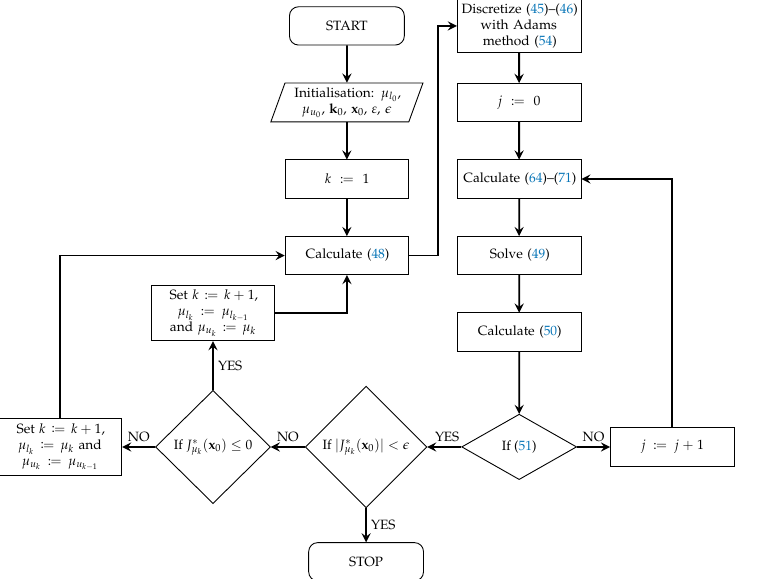
Figure 2. Flowchart of algorithmic procedure for calculation of PID controller gains and determination of the “worst case” of sensors fault functions.